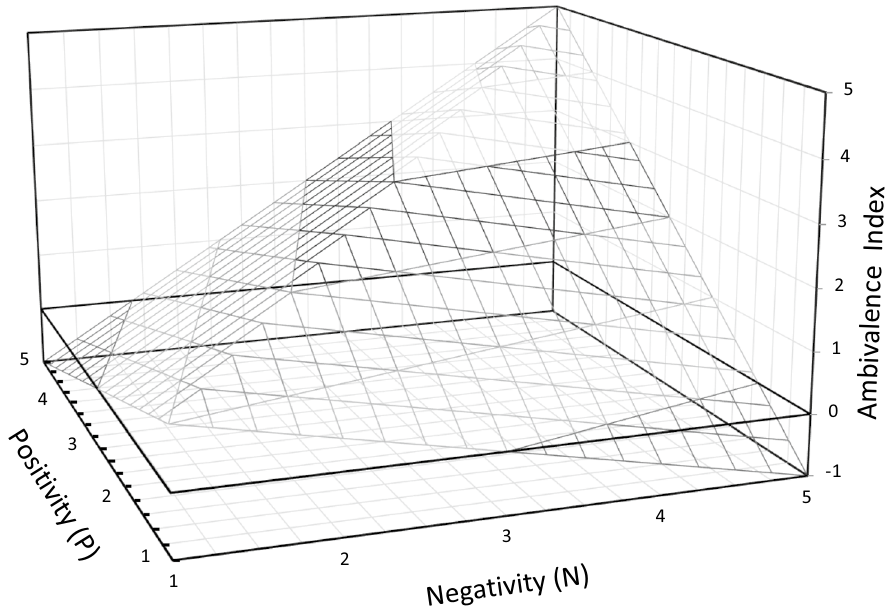
Figure 1. Schematic representation of the ambivalence